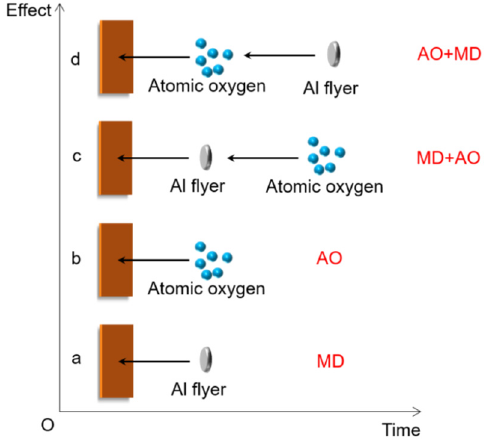
Figure 3. Schematic diagram of four load spectrum tests.